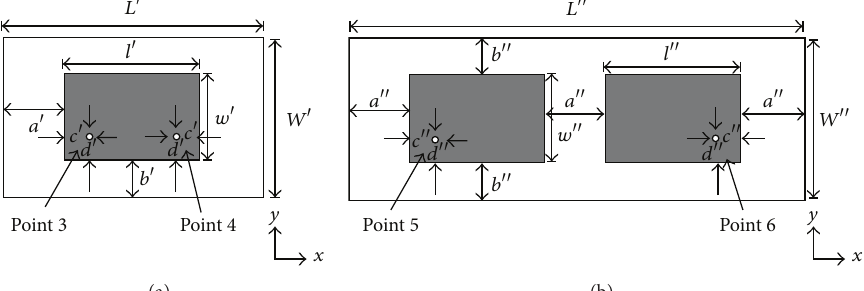
Figure 7: Two cases of modified feeding structures for reducing cross polarization: (a) 𝐿 󸀠 = 98 mm, 𝑊 󸀠 = 60 mm, 𝐻 󸀠 = 2.4 mm, 𝑤 󸀠 = 20 mm, 𝑙 󸀠 = 34 mm, 𝑎 󸀠 = 32 mm, 𝑏 󸀠 = 20 mm, 𝑐 󸀠 = 7 mm, and 𝑑 󸀠 = 7 mm and (b) 𝐿 󸀠󸀠 = 128 mm, 𝑊 󸀠󸀠 = 60 mm, 𝐻 󸀠󸀠 = 2.4 mm, 𝑤 󸀠󸀠 = 20 mm,